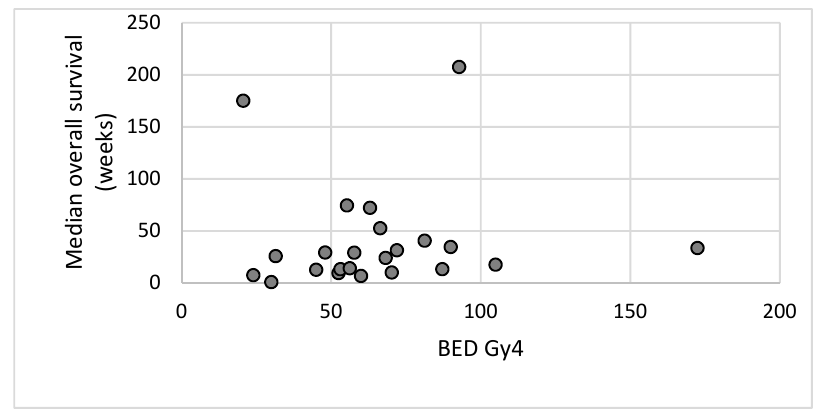
Figure 4. This figure demonstrates the median overall survival of patients plotted against BED for each dose/fractionation regime.